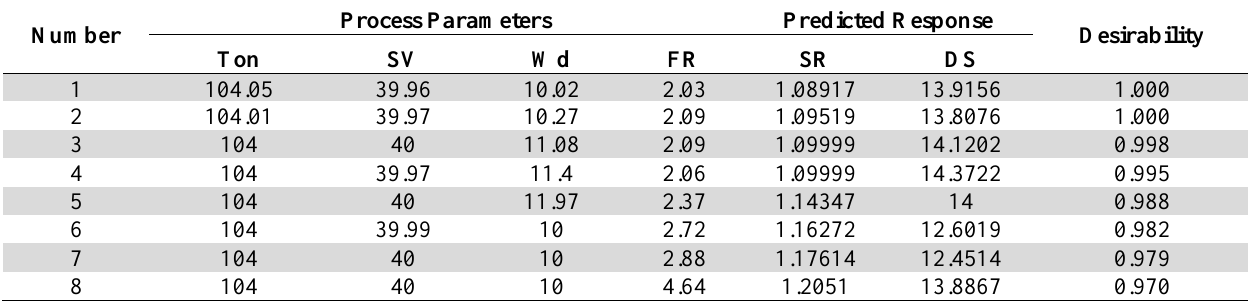
Process parameters combination for high value of